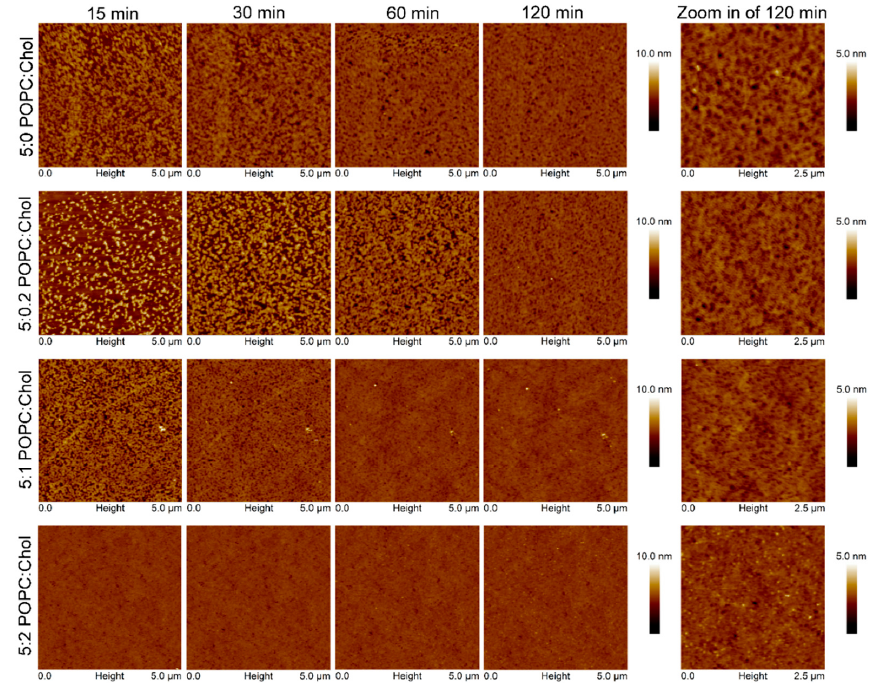
Figure 5. Time sequence AFM images of Cyt2Aa2 protein binding on lipid bilayers with different levels of cholesterol content. Once the lipid bilayer formation was confirmed by tip indentation, Cyt2Aa2 of 25 µg/mL was introduced into the fluid cell chamber. AFM images were collected in tapping mode with scan rate of 1–2 Hz in 5 µm × 5 µm. The final topographic images are zoomed in to reveal the topographic pattern of protein–lipid binding.